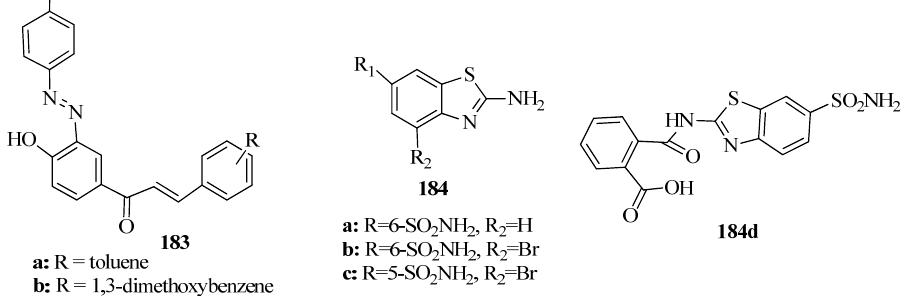
Figure 70. Structures of sulfonamide derivatives.